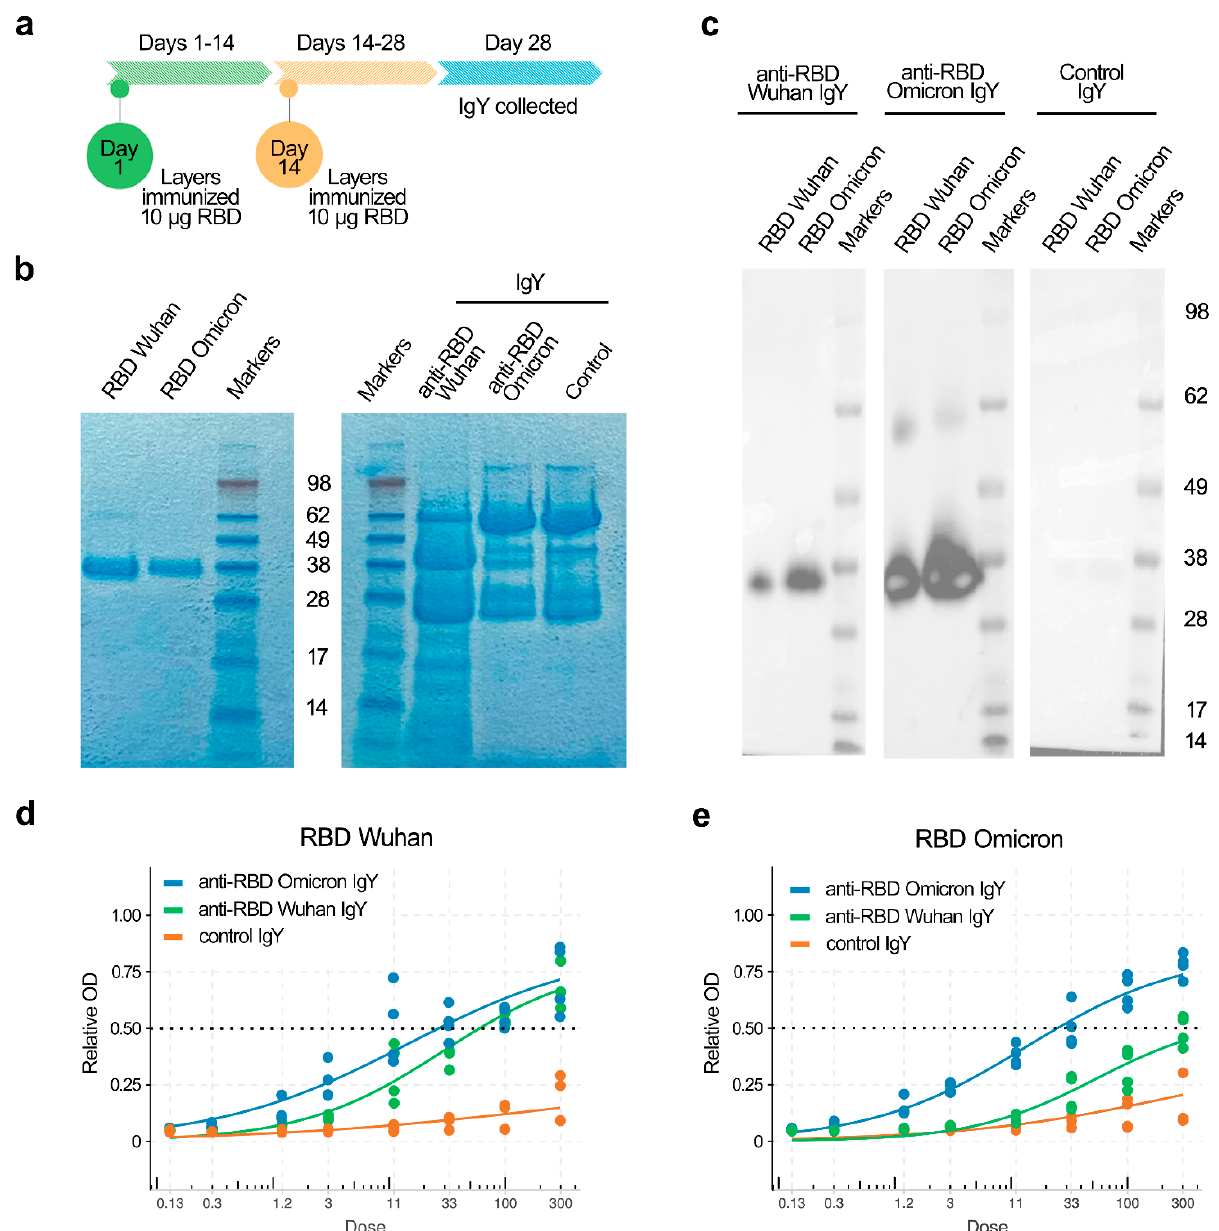
Figure 1. IgY antibodies produced in chicken eggs in response to immunization of layers with receptor-binding domains (RBD) of spike glycoproteins (S) of Wuhan and Omicron SARS-CoV-2 virus variants bind and cross-react with purified RBDs of S proteins of Wuhan and Omicron SARS-CoV-2 variants. ( a ) Layers were immunized twice at 14-day intervals using purified RBD of SARS-CoV-2. IgYs were extracted from eggs harvested 14 days after the second immunization. ( b ) SDS-PAGE of purified RBDs of S of Wuhan and Omicron variants, as well as corresponding anti-RBD and control IgYs. ( c ) Binding of anti-RBD_Wuhan, anti-RBD_Omicron, or control IgY to Wuhan and Omicron RBDs analyzed by immunoblot. ( d ) Binding of anti-RBD_Wuhan, anti-RBD_Omicron, or control IgYs to Wuhan RBD measured by indirect ELISA (OD at 650 nm). Mean; n = 4 (2 experiments with 2 parallels). ( e ) Binding of anti-RBD_Wuhan, anti-RBD_Omicron, or control IgYs to Omicron RBD measured by indirect ELISA (OD—650 nm). Mean; n = 4 (2 experiments with 2 parallels).